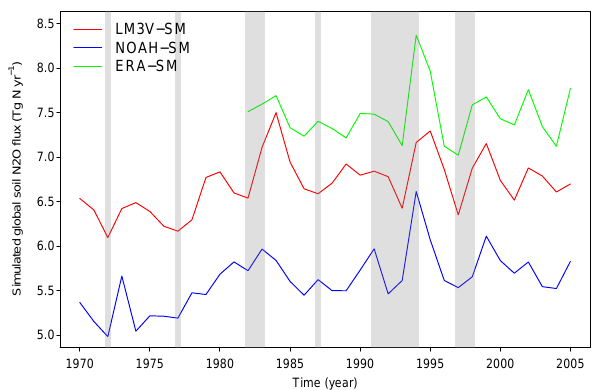
Figure 1. Simulated annual global soil N 2 O emissions based on po- tential vegetation (1970–2005). Shaded grey area indicates El Niño years with the annual multivariate ENSO index (MEI) greater than 0.6. Colours refer to different soil moisture data set used in the es- timation: red for LM3V-SM (with WFPS calculated by Method 3); blue for NOAH-SM (Method 2) and green for ERA-SM (Method 2). Details for these soil moisture data sets and WFPS calculating methods are available in the main